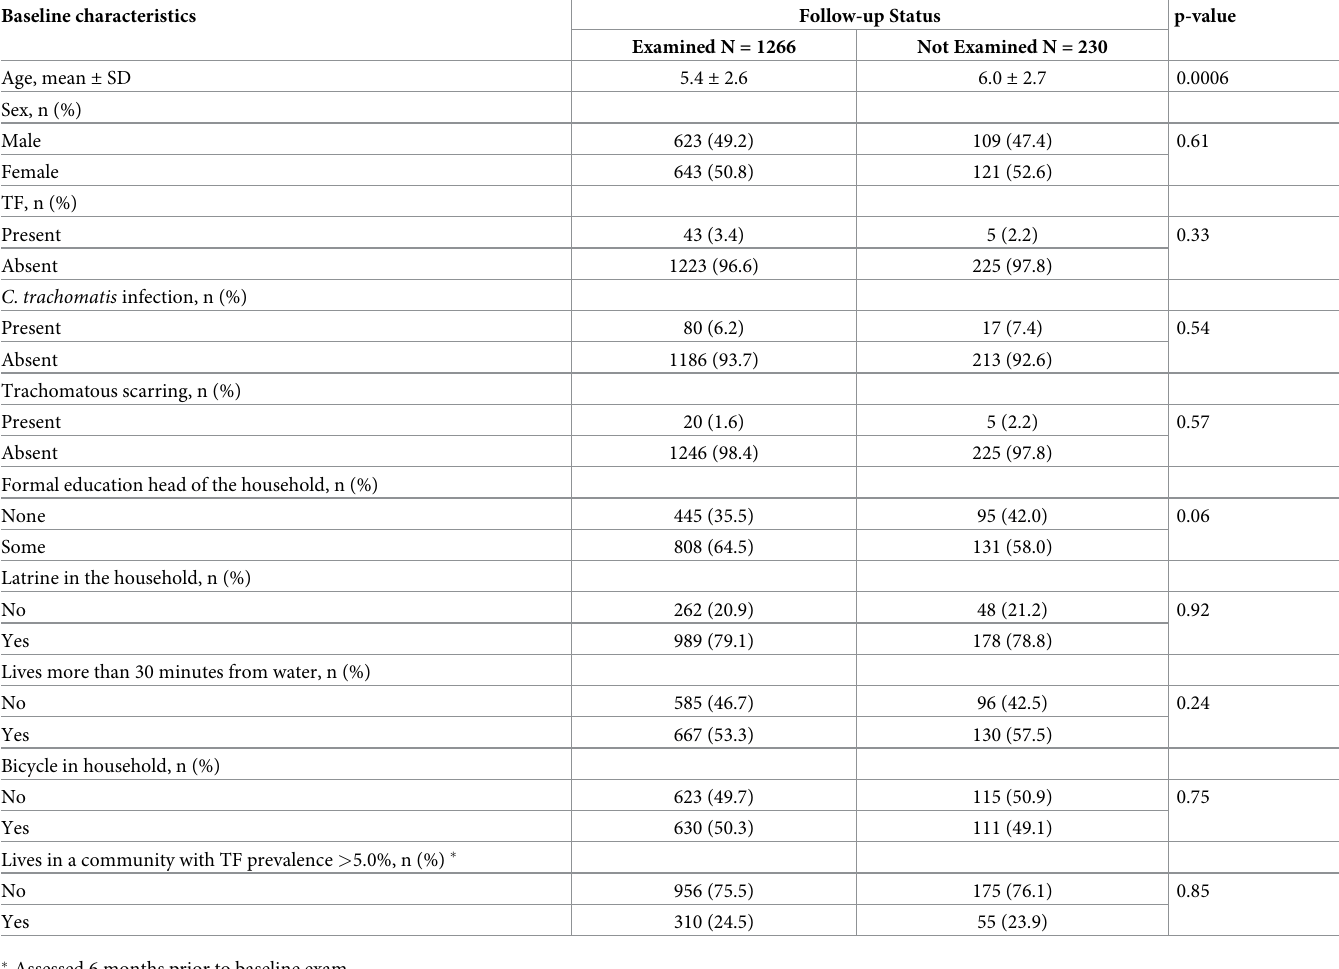
Table 2. Baseline characteristics by follow-up